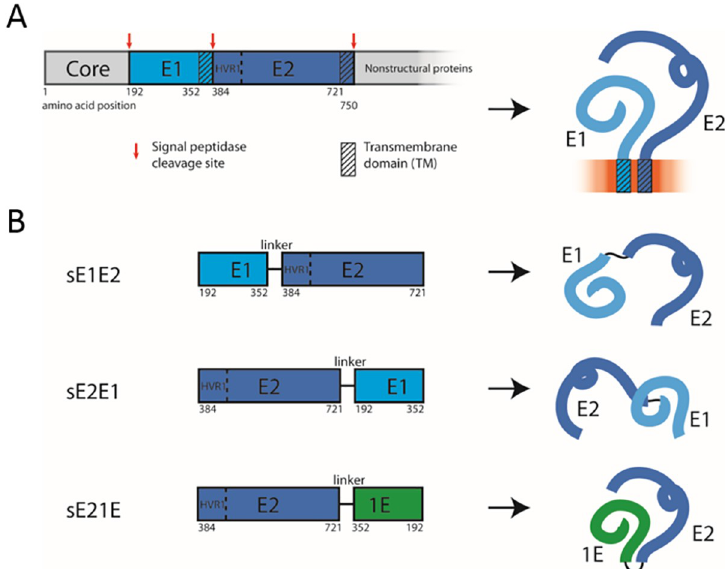
Fig 1. Schematic representations of HCV envelope proteins E1 and E2 as well as soluble permutated variants. A) Left panel, bar representation of the HCV polyprotein, focused on the structural proteins. E1 is followed by E2 and both are cleaved at the end of their respective transmembrane domains (TM) by signal peptidase. Numbering refers to the amino acid sequence of the J6 polyprotein (Genbank # AF177036). HVR1, hypervariable region 1. Right panel, line representation of folded E1/E2 heterodimers embedded in a membrane. B) Left panel, bar representation of permutated, TM-deleted HCV envelope protein variants sE1E2, sE2E1, and sE21E (shown with a linker sequence, GGSAWSHPQFEKGG, between the E1 and E2 constituents). To illustrate how envelope protein variants were derived, the amino acid numbering refers to their numbered positions as shown in panel A.